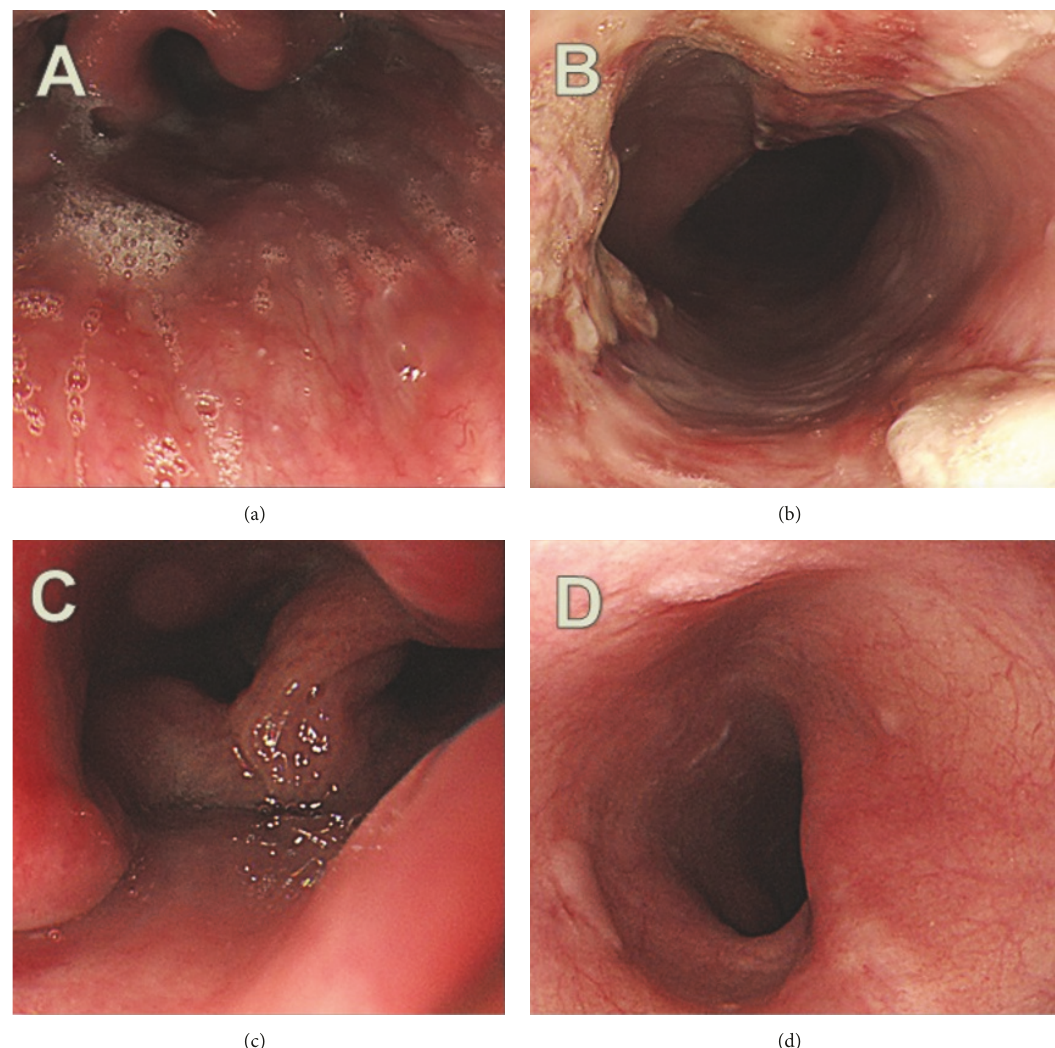
Figure 3: Upper endoscopy after conservative treatment. Endoscopic finding one week after thermal injury ((a) and (b)). The epiglottis was nearly healed and diffuse ulcerative lesions of the esophagus were improving without more bleeding. Endoscopic finding one month after thermal injury ((c) and (d)). The epiglottis was completely healed and whitish scars were seen in the